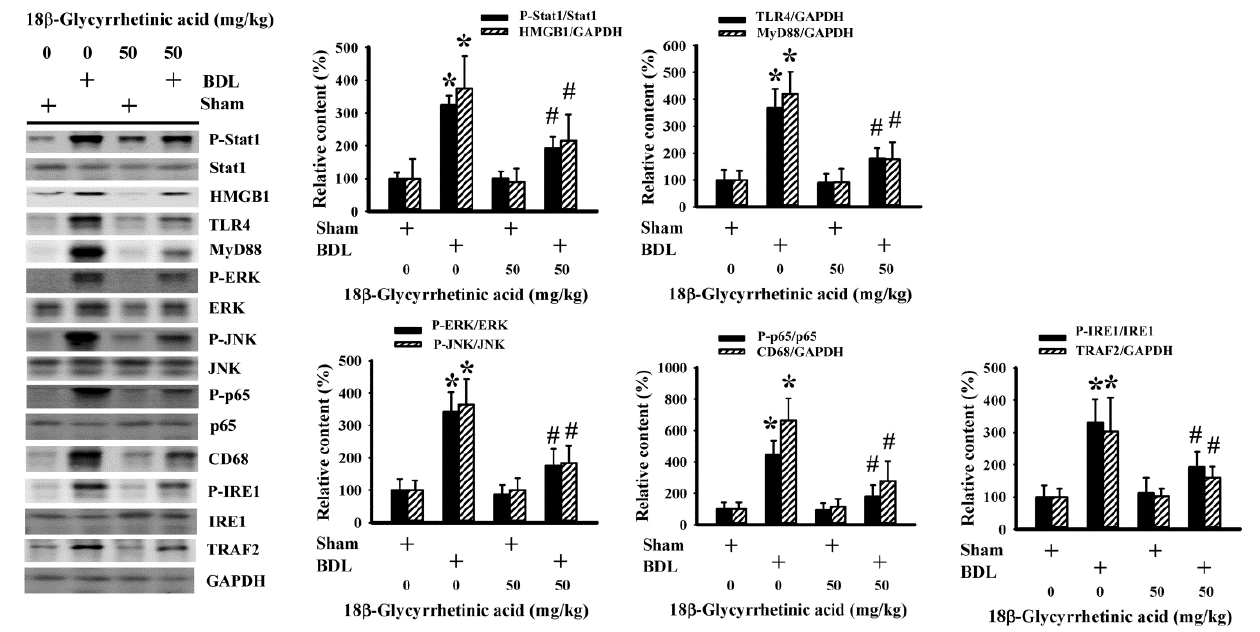
Figure 8. 18 β -Glycyrrhetinic acid alleviated BDL-induced inflammatory signaling in the treatment study. Protein contents in liver tissues were measured using Western blot with indicated antibodies. Representative blots and the quantitative data are shown. * p < 0.05 vs. the sham vehicle group and # p < 0.05 vs. the BDL vehicle group, n = 8.